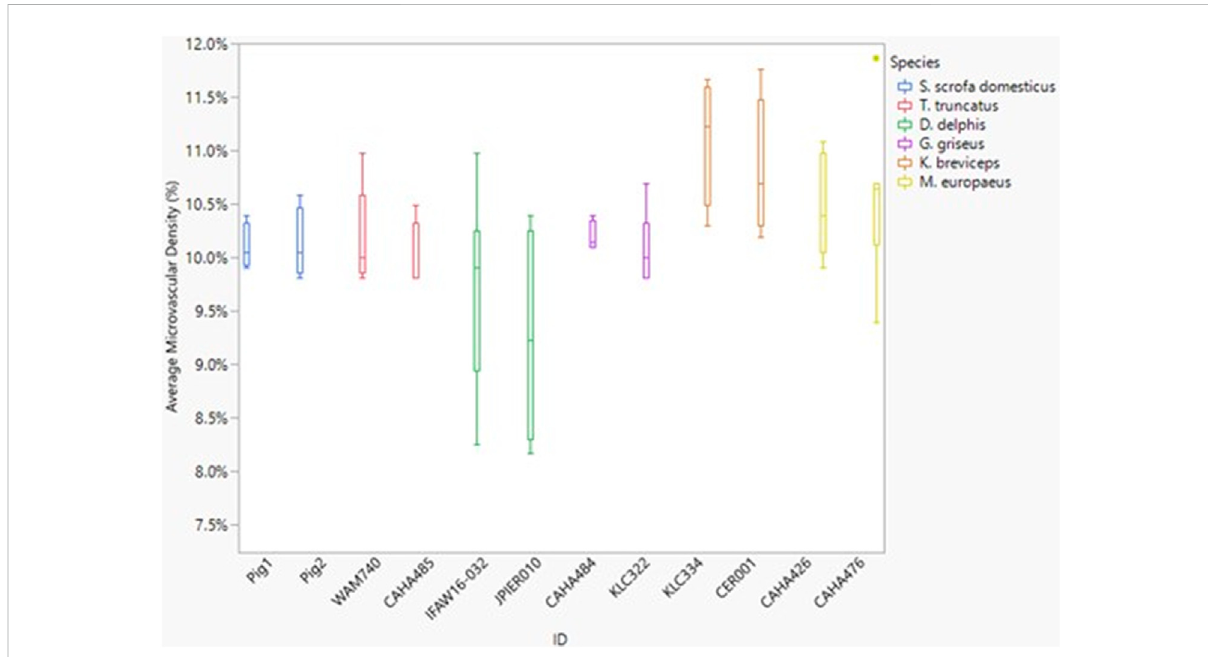
FIGURE 4 Box and whisker plot of average microvessel density versus Animal ID color-coded by species. Horizontal lines from top to bottom: maximum, third quartile, median, fi rst quartile, minimum. Dots represent outliers.